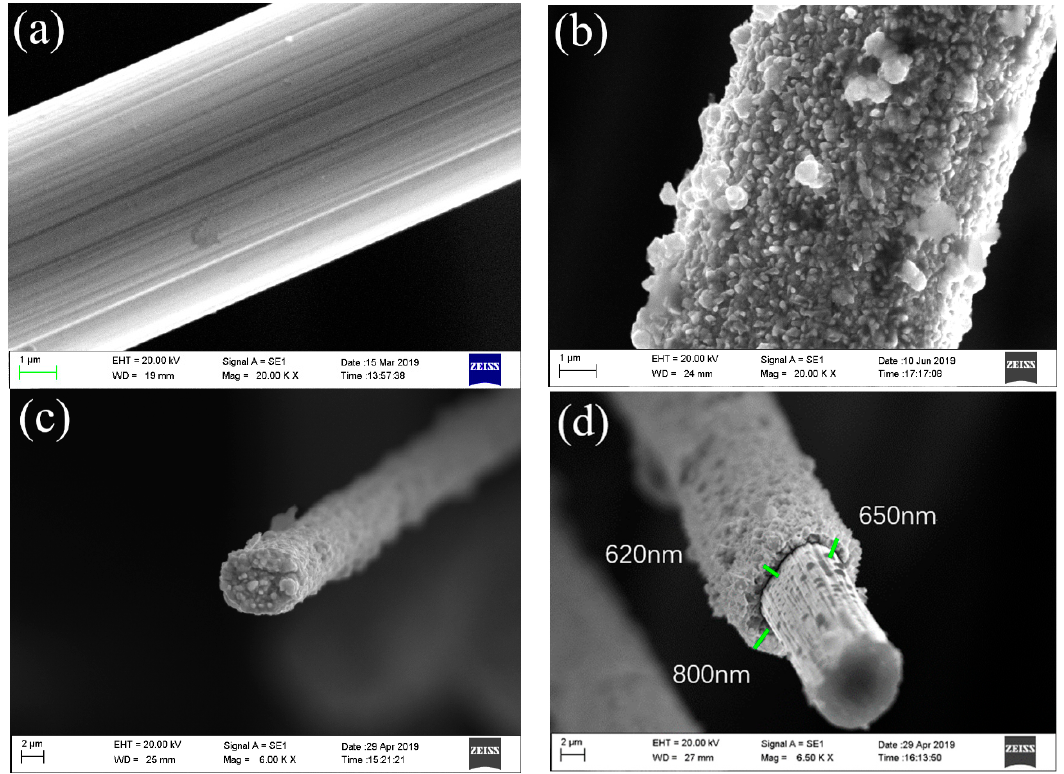
Figure 2. The micro morphology of Cu-coated braided carbon fiber rope: ( a ) as-received carbon fiber; ( b ) surface coating of carbon fiber; ( c ) ends of copper plated carbon fiber; ( d ) cross section of copper plated carbon fiber.